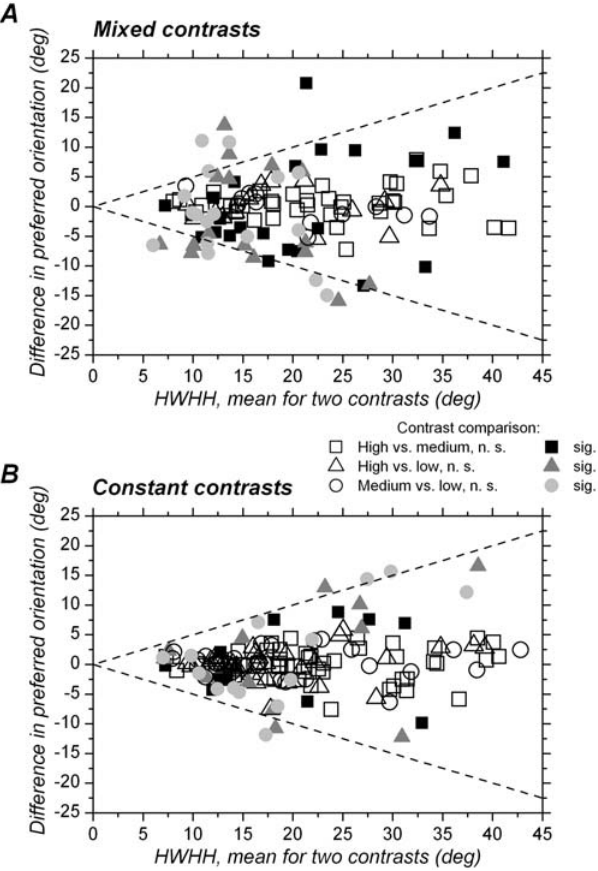
Figure 7. Changes in preferred orientation vs. half-width at half-height of tuning curves. A. Mixed contrasts. B. Constant contrasts. The x -axis corresponds to the mean of the two HWHHs obtained with the two contrasts that are compared. The y -axis represents the difference in preferred orientation observed with the same contrasts. Squares: high compared to medium contrast. Triangles: high compared to low contrast. Circles: Medium compared to low contrast. Cells for which preferred orientation changed significantly (p , 0.05, t test) are represented by filled symbols (‘‘sig’’) and cells for which preferred orientation did not change significantly by open symbols (‘‘n. s.’’). The diagonals represent the relation y = 6 0.5 x . Data points between the diagonals correspond to cells for which the difference in preferred orientation is less than the mean HWHH.